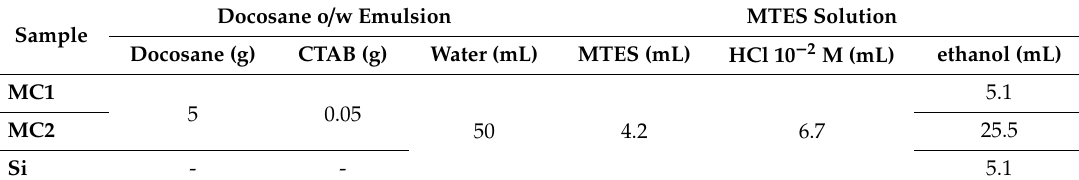
Table 1. Composition of the docosane o/w emulsion and the MTES solution for all the prepared samples.